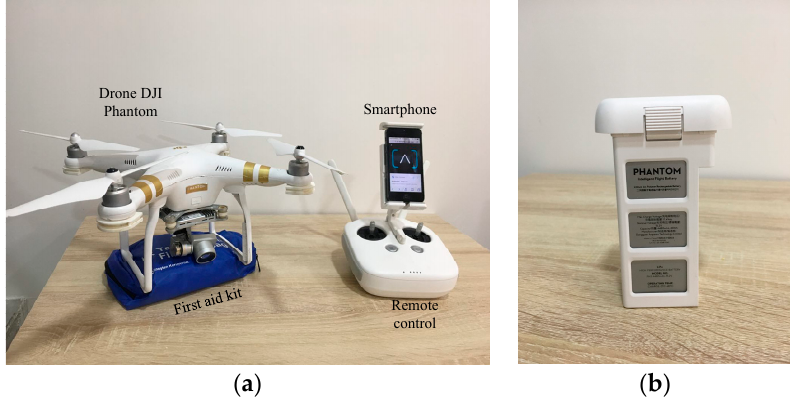
Figure 4. UAV adopted to deliver first aid; ( a ) All components of the DJI Phantom 3, ( b ) Battery pack.